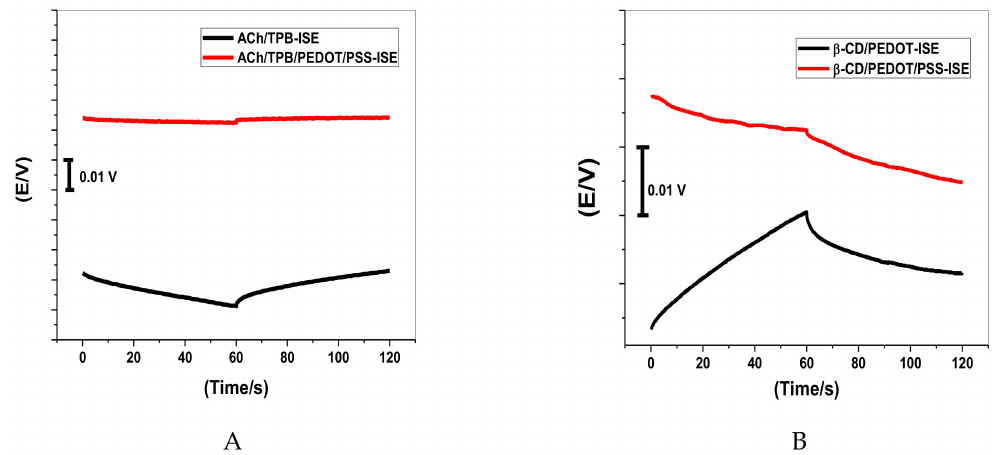
Figure 2. Chronopotentiograms (applied current: + 1 nA for 60 s and − 1 nA for 60 s) for all-solid-state acetylcholine (ACh + ) ion-selective electrode (ISE) based on ( A ) tetraphenylborate (TPB) and ( B ) β -cyclodextrin ( β